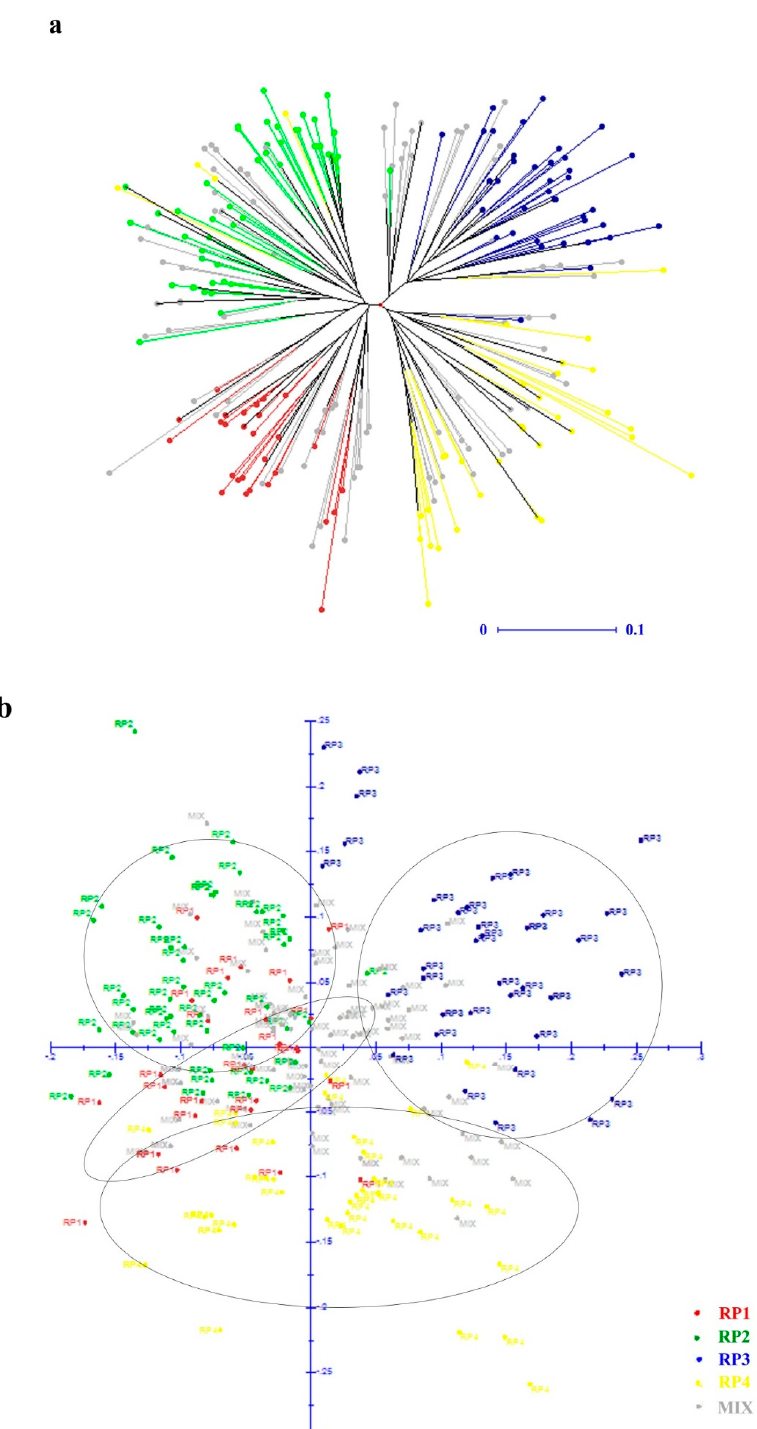
Figure 3. Relationships of the 251 Dalbergia odorifera individuals. ( a ) An unweighted NJ (neighbor-joining) tree based on the dissimilarity matrix calculated with Manhattan index among 251 D. odorifera individuals. ( b ) Principal coordinate analysis (PCA) based on the dissimilarity matrix, the x-axis, the first principal coordinate explained 9.67% of variation; the y-axis, the second principal coordinate explained 8.20% of variation.